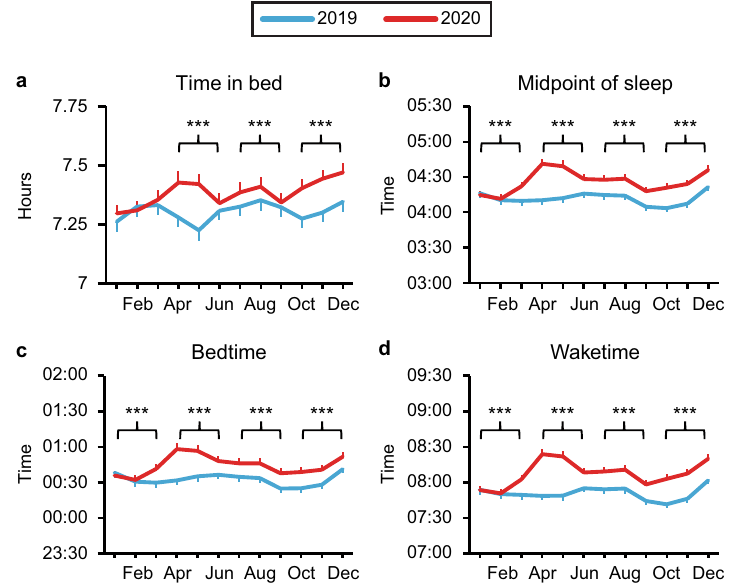
Figure 1. Global changes in sleep duration and timing between 2019 and 2020. Worldwide average time in bed ( a ) and midpoint of sleep ( b ) were calculated from self-reported bedtimes ( c ) and waketimes ( d ) for each quarter in 2019 (blue) and 2020 (red). Bonferroni-adjusted p values for comparisons between each quarter of 2019 to the corresponding quarter of 2020 are indicated as follows: * p < 0.05, ** p < 0.01, *** p < 0.001. Means ± SEM are